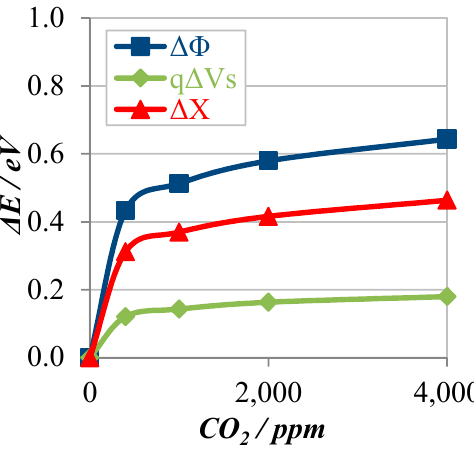
Figure 5. Variation of work function, band bending, and electron affinity with CO 2